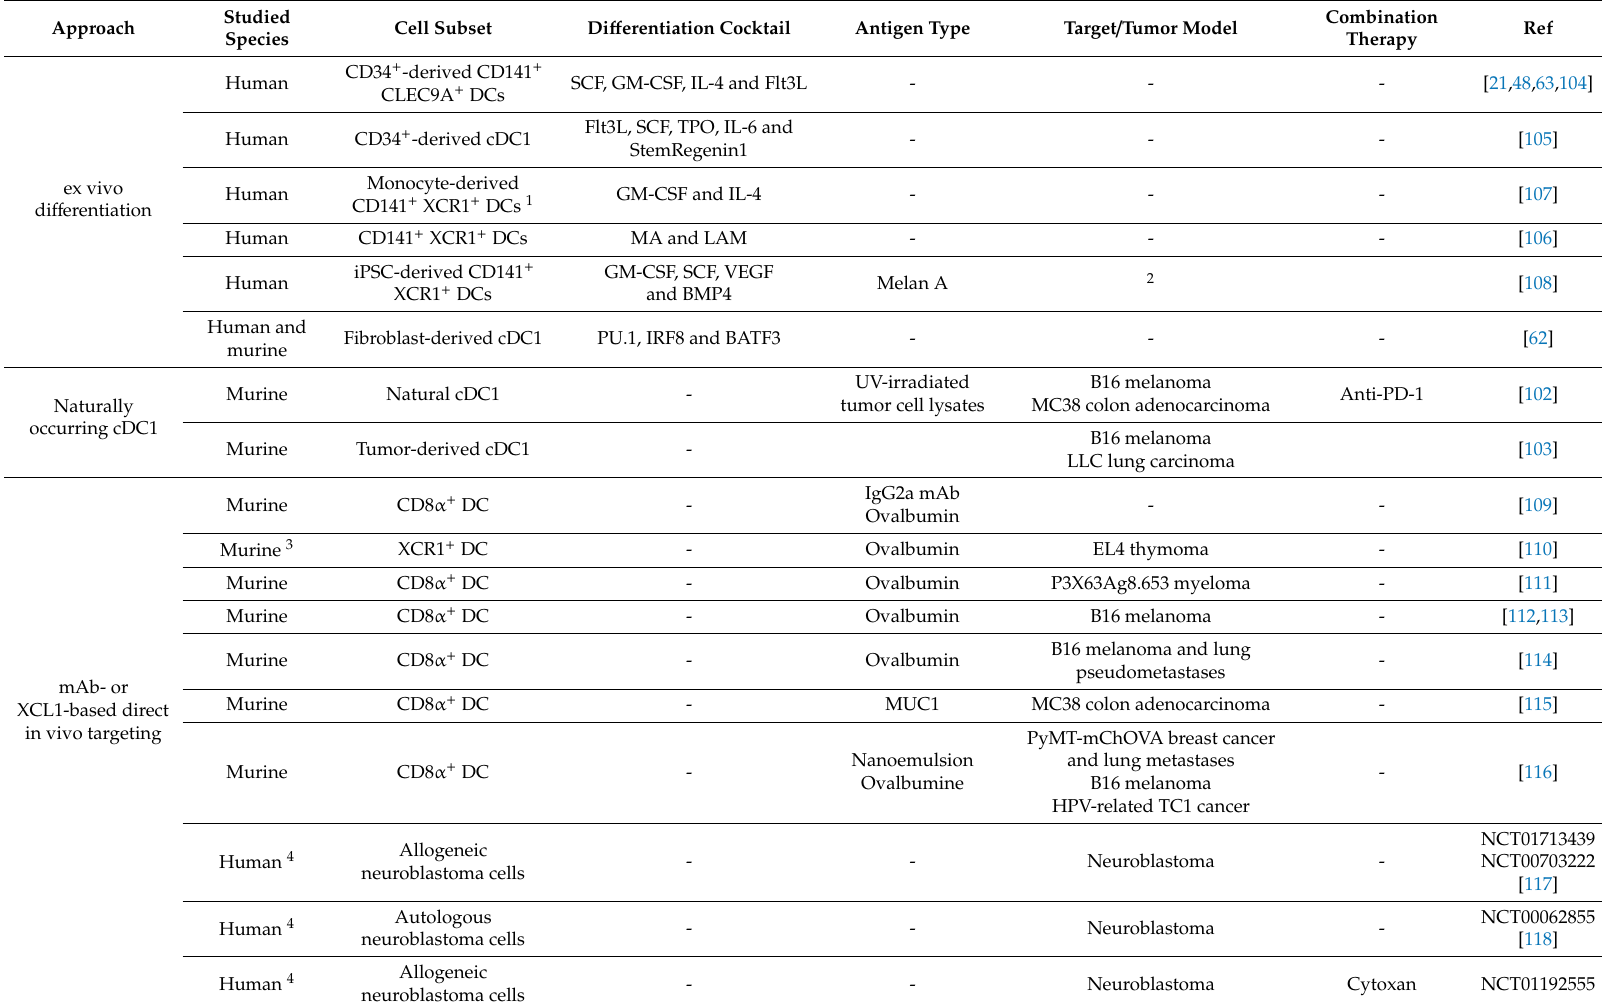
Table 1. Overview of existing approaches aiming to explore cDC1s for anti-tumor